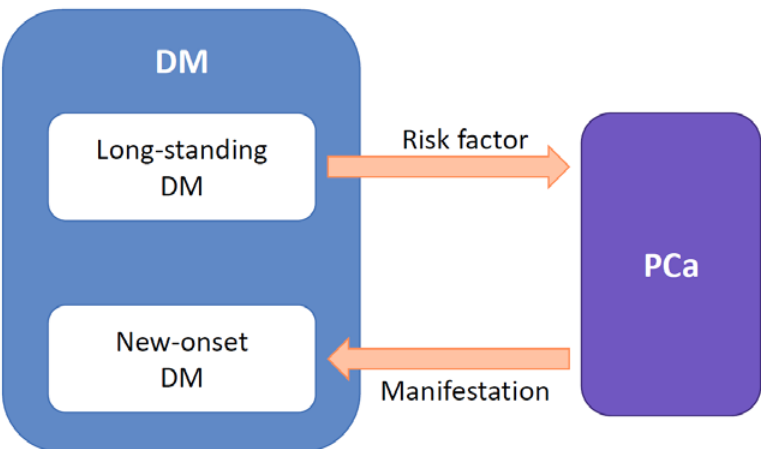
Figure 1. Bidirectional causality between diabetes mellitus (DM) and pancreatic cancer (PCa). Long-standing DM ( > 2-year duration) is a risk factor for PCa, meanwhile new-onset DM ( ≤ 2-year duration) is a manifestation of PCa.